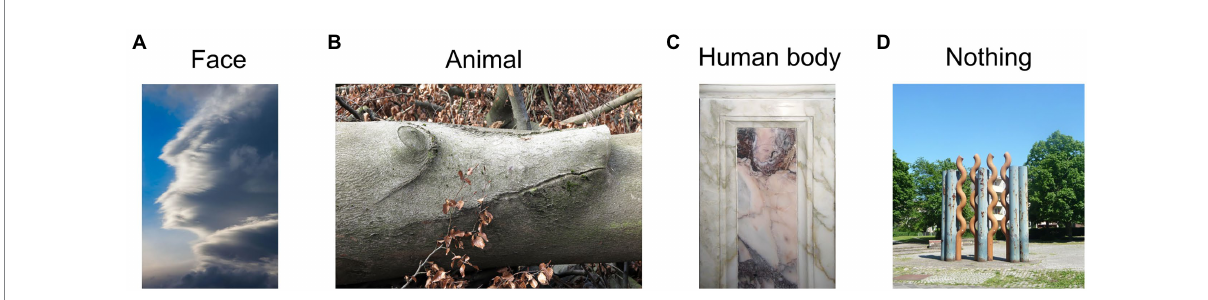
FIGURE 3 Example picture pareidolia stimuli. Reproduced unchanged from Wikimedia Commons. (A) Photograph by Frank Kovalchek. 2012. Wikimedia.org. https://commons.wikimedia.org/wiki/File:Interesting_cloud_-_it_looks_like_the_face_of_a_superhero_(8352871256).jpg CC BY 2.0. (B) Photograph by Rolf Brecher. 2018. Wikimedia.org. https://commons.wikimedia.org/wiki/File:Gemeines_Baumschwein_(40153933314).jpg CC BY 2.0. (C) Photograph by Fabiolinux25. 2009. Wikimedia.org. https://commons.wikimedia.org/wiki/File:Pareidolia_-_Chiesa_Madre_di_Nereto_-_ Teramo,_Italy.jpg Public domain image. (D) Photograph by Immanuel Giel. 2013. Wikimedia.org. https://commons.wikimedia.org/wiki/ File:Rostiges_Metall_%3D_moderne_Kunst_-_panoramio_(1).jpg CC BY